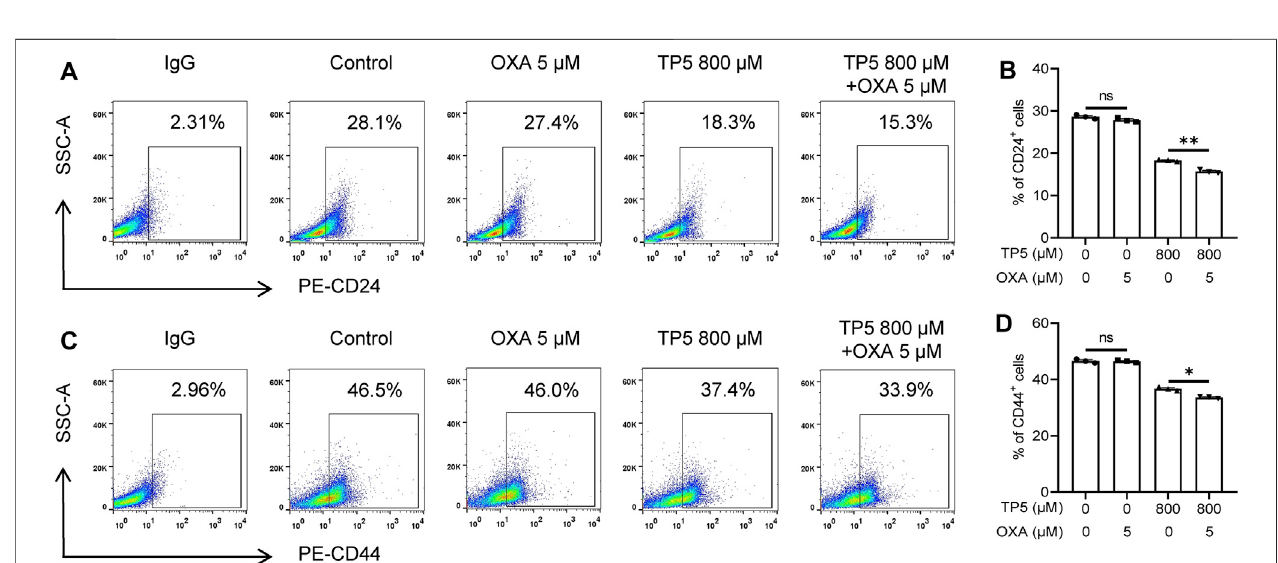
FIGURE 7 | TP5 promotes the inhibitory effect of OXA on colon cancer stem cells. (A – D) Flow cytometer analysis of the expression of CD24 (A) and CD44 (C) in HCT116 cells after OXA and TP5 treatments, and pooled data of cell surface markers CD24 (B) , CD44 (D) ( n = 3 independent experiments). All data are represented as mean ± SD; * p < 0.05 and ** p < 0.01, unpaired two-tailed Student ’ s t -test. ns, not signi fi cant.